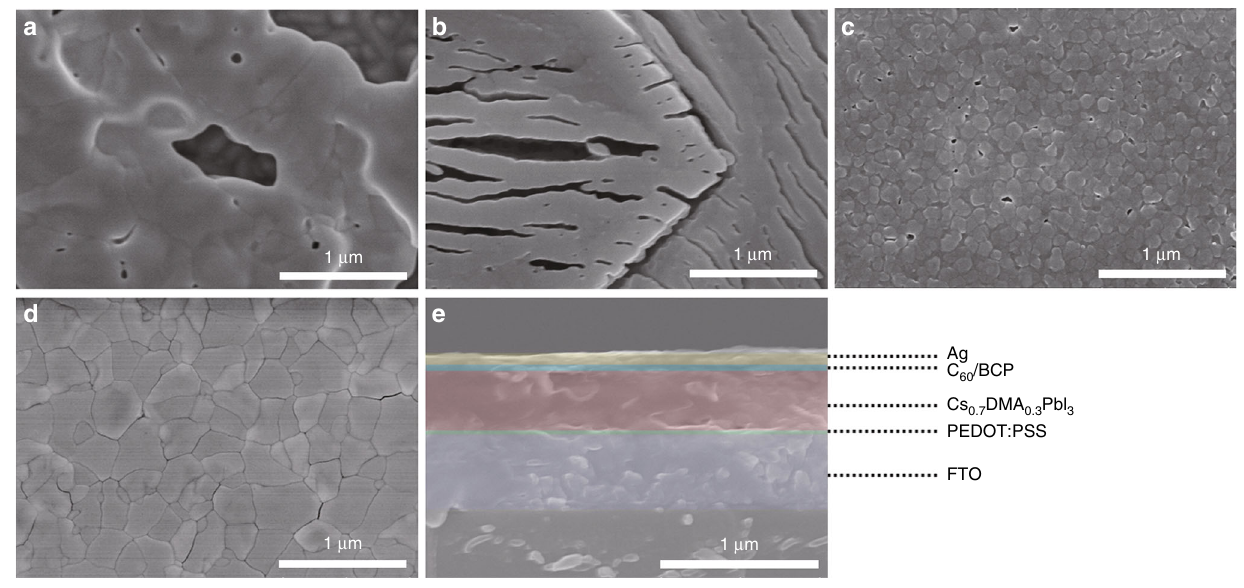
Fig. 3 Film and device morphology. Top view SEM images of a a CsPbI 3 , b a DMAPbI 3 , c a HI-treated CsPbI 3 , and d a Cs 0.7 DMA 0.3 PbI 3 fi lm deposited on FTO/PEDOT substrates. e Cross-sectional SEM image of a completed device using a PEDOT:PSS hole transporting layer, a Cs 0.7 DMA 0.3 PbI 3 absorber, a C 60 /BCP electron transporting layer, and a Ag metal electrode